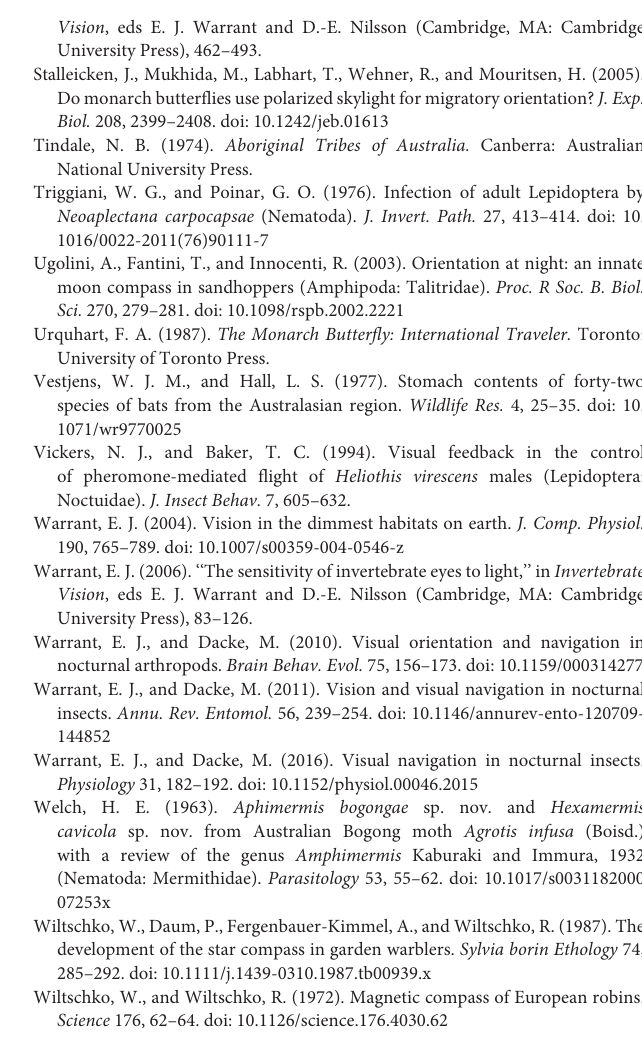
headings and layering of nocturnally migrating insects. Proc. Biol. Sci. 277, 765–772. doi: 10.1098/rspb.2009.1221 Riley, J. R. (1989). ‘‘Orientation by high-flying insects at night: observations and theories,’’ in Paper Presented at the Conference of the Royal Institute of Navigation, Cardiff, Orientation and Navigation–Birds, Humans and Other Animals ,